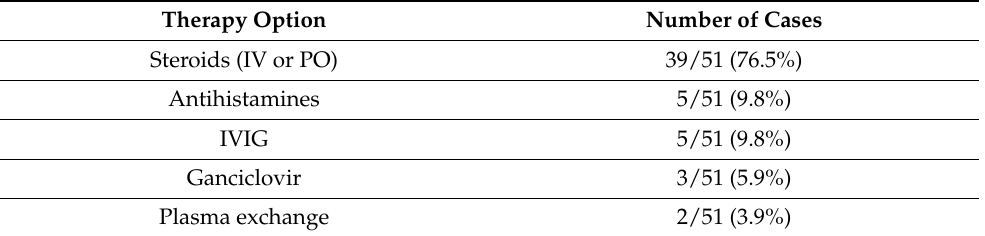
Table 6. This table summarizes the treatment patients received during